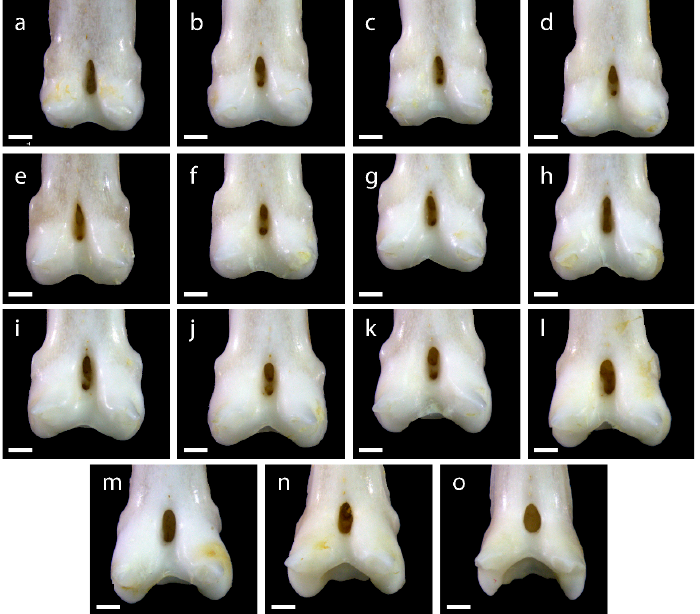
Figure A2. Microscopic images of the posterior view of the pinnules of P. bichir PO2. The images ( a – o ) correspond to the 1st, 2nd, 3rd, 4th, 5th, 6th, 7th, 8th, 9th, 10th, 11th, 12th, 13th, 14th, and 15th pinnules, respectively. Scale bars = 1 mm.